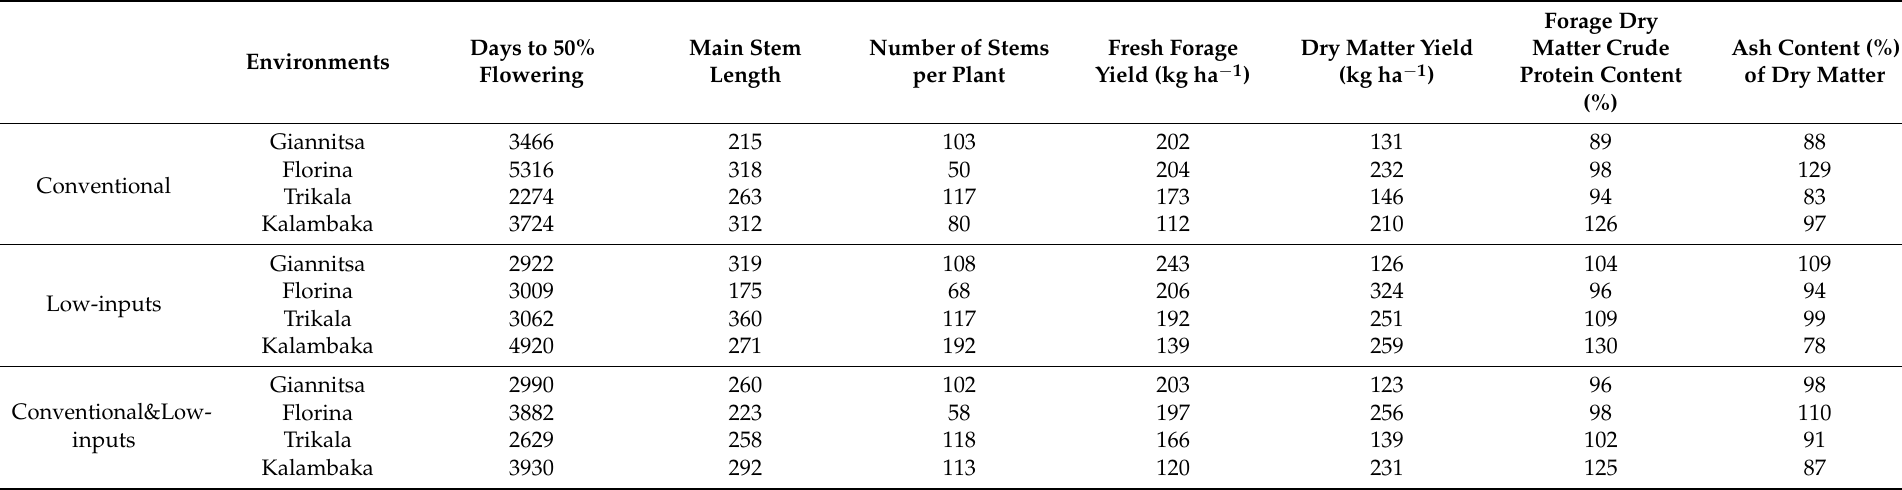
Table 2. Trait stability index across environments for two farming systems: days to 50% flowering, main stem length, number of main stems per plant, fresh forage yield (kg ha − 1 ), dry matter yield (kg ha − 1 ), forage dry matter crude protein content (%) and ash content (%) of dry